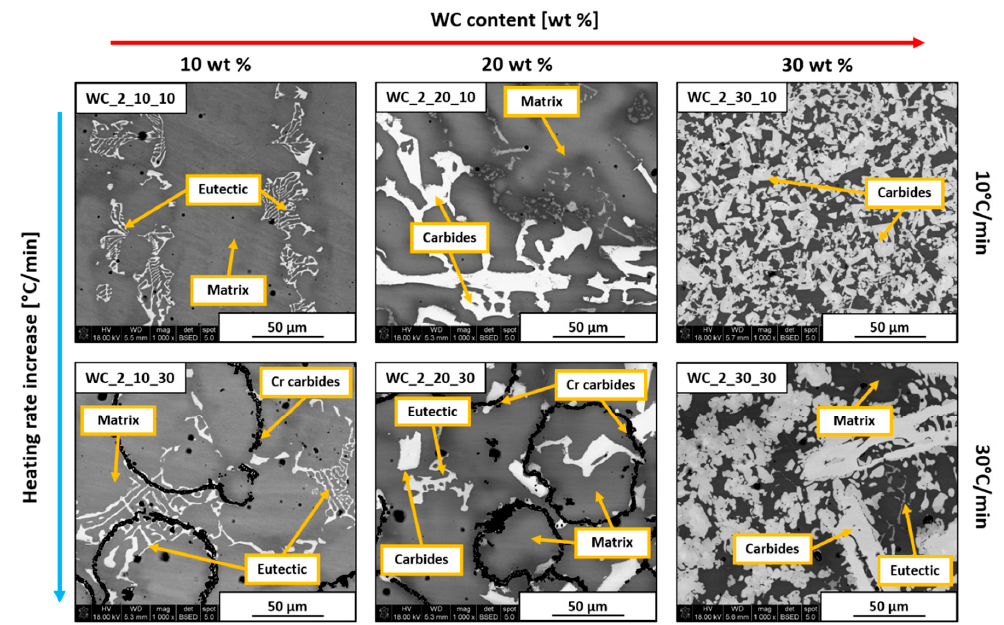
Figure 6. SEM images of Inconel 625–WC_2 sample cross-sections.